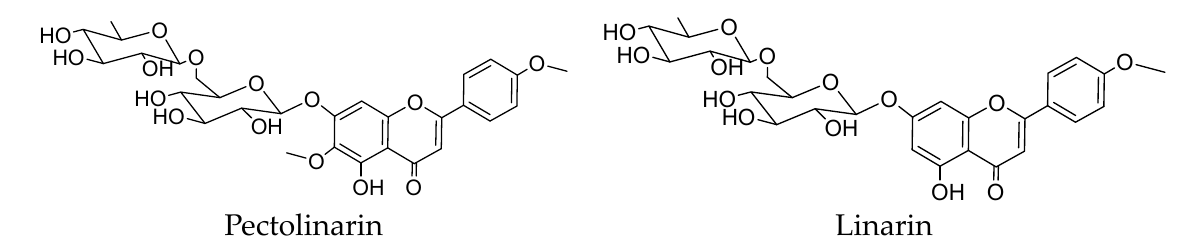
Figure 1. Chemical structure of pectolinarin and linarin.